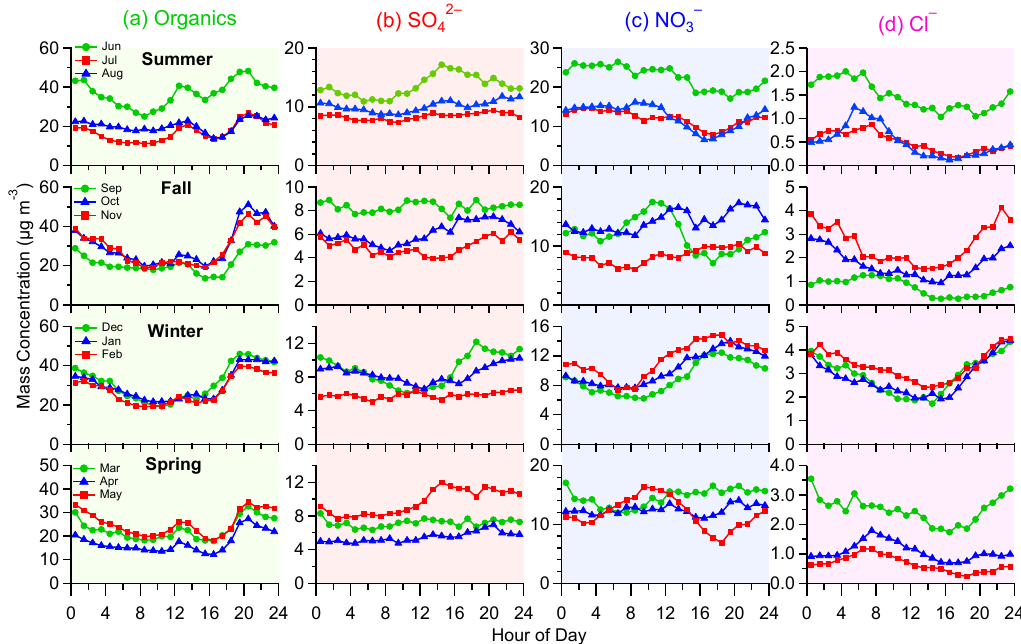
Figure 7. Monthly average diurnal cycle of (a) organics, (b) sulfate, (c) nitrate, and (d) chloride during the four